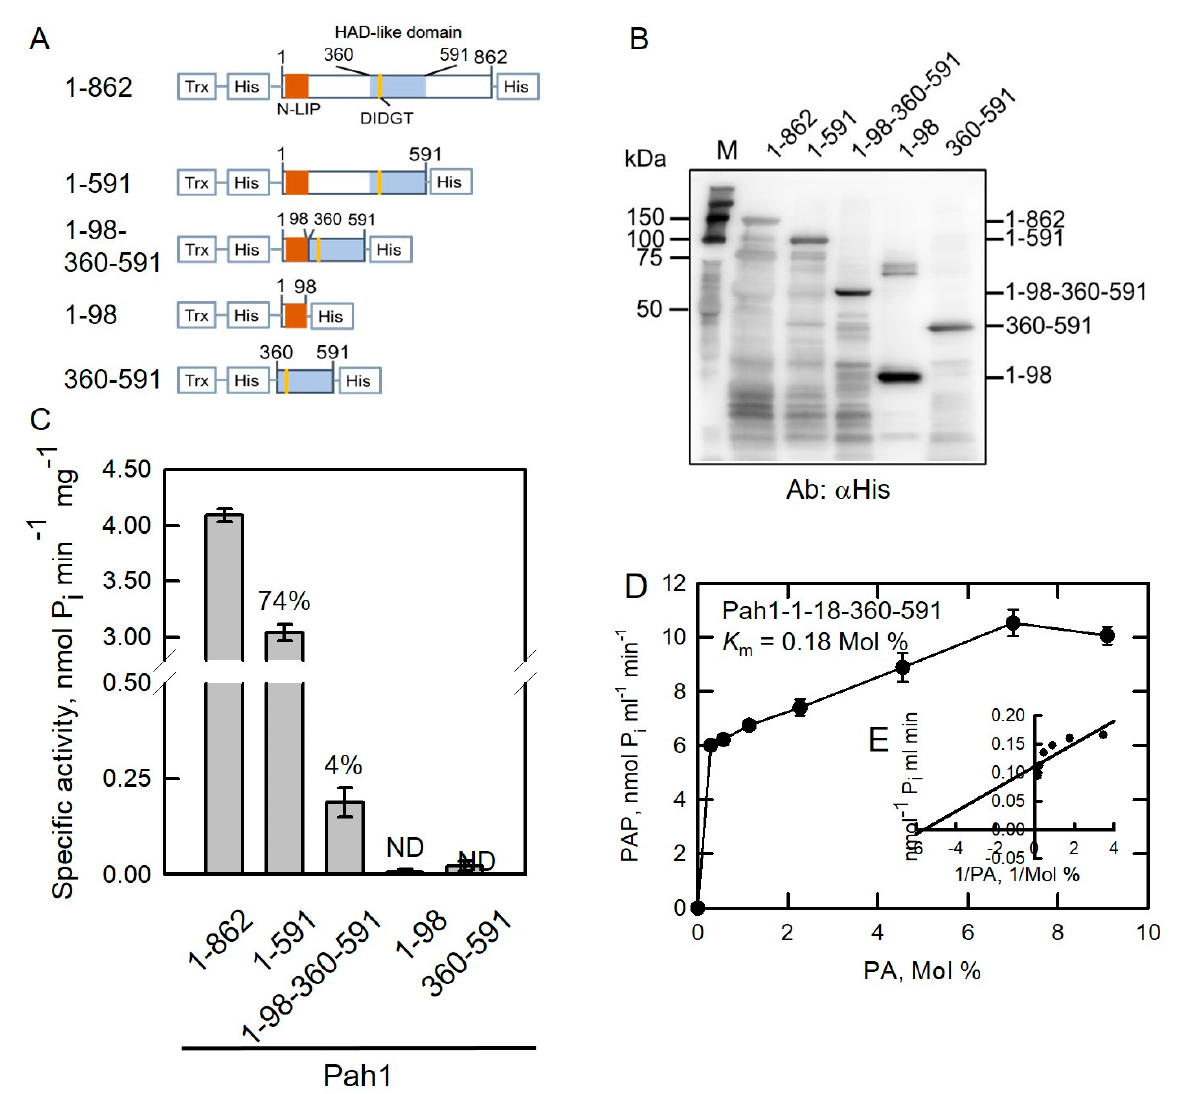
Figure 3. NLIP domain is essential for Pah1 catalytic activity. ( A ) The full-length and truncated Pah1 proteins fused with thioredoxin (Trx) and His 6 -tags at both termini. ( B ) Pah1 truncations were expressed in E. coli and purified by Ni-NTA resin. Proteins were subjected to SDS-PAGE followed by Western blotting analysis with the anti-His antibodies. ( C ) PAP activities were measured in Pah1 truncations. ( D ) Substrate saturation curve and Lineweaver–Burk double reciprocal plot ( E ) of the initial rate result of Pah1-1-98-360-591. The data are the average of triplicate experiments ± S.D. (error bars). ND, not detected.